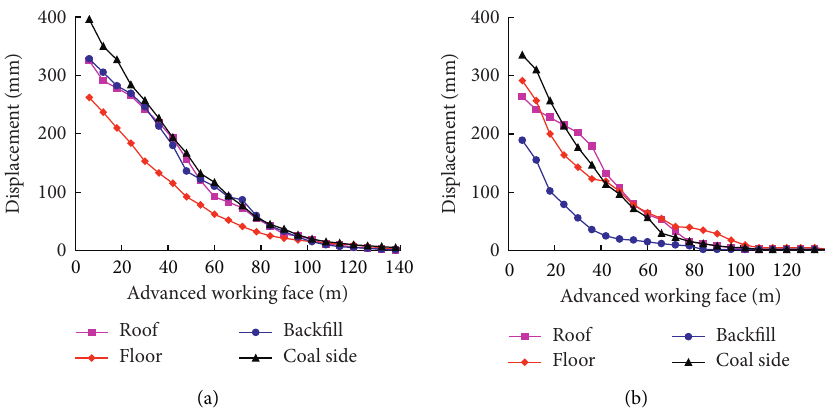
Figure 12: Displacement curve of surrounding rock with the mining of working face. (a) Displacement curve of surrounding rock in section 1; (b) displacement curve of surrounding rock in section